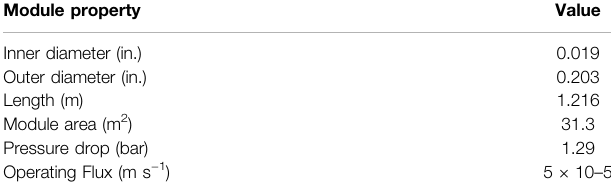
TABLE 9 | Module properties for customized